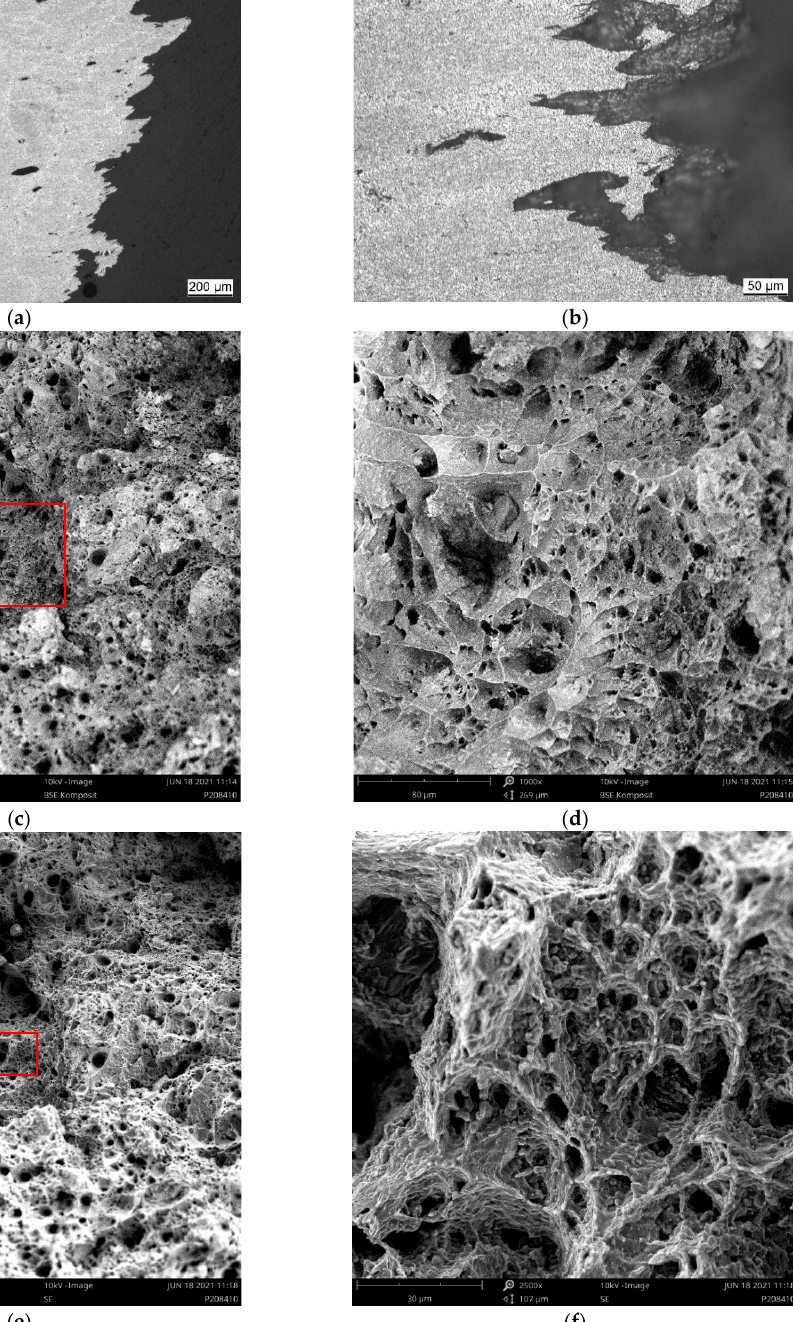
Figure 11. Region of fracture of a sample of polar angle 0° tested at 450 °C: ( a , b ) metallographic section of etched samples at different magnifications, ( c , d ) back-scattered electron (BSE) images of the fracture surface at different magnifications and ( e , f ) secondary electron (SE) images of the fracture surface, overview and detailed view. Note that the red box in the image on the left highlights the area depicted in the magnified view on the right. Figure 12 contrasts samples of build orientations (polar angle) 0 ◦ , 45 ◦ and 90 ◦ , all